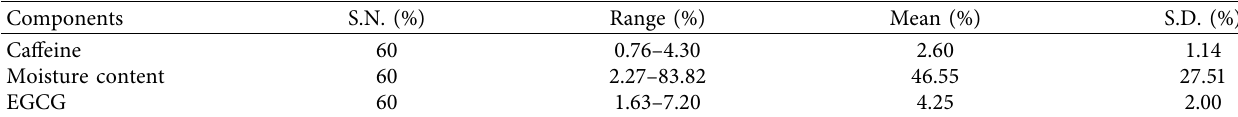
Table 2: Reference measurements and the number of samples in the testing